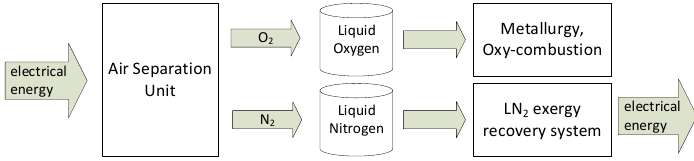
Figure 1. Principle of LN 2 based energy storage system operation.